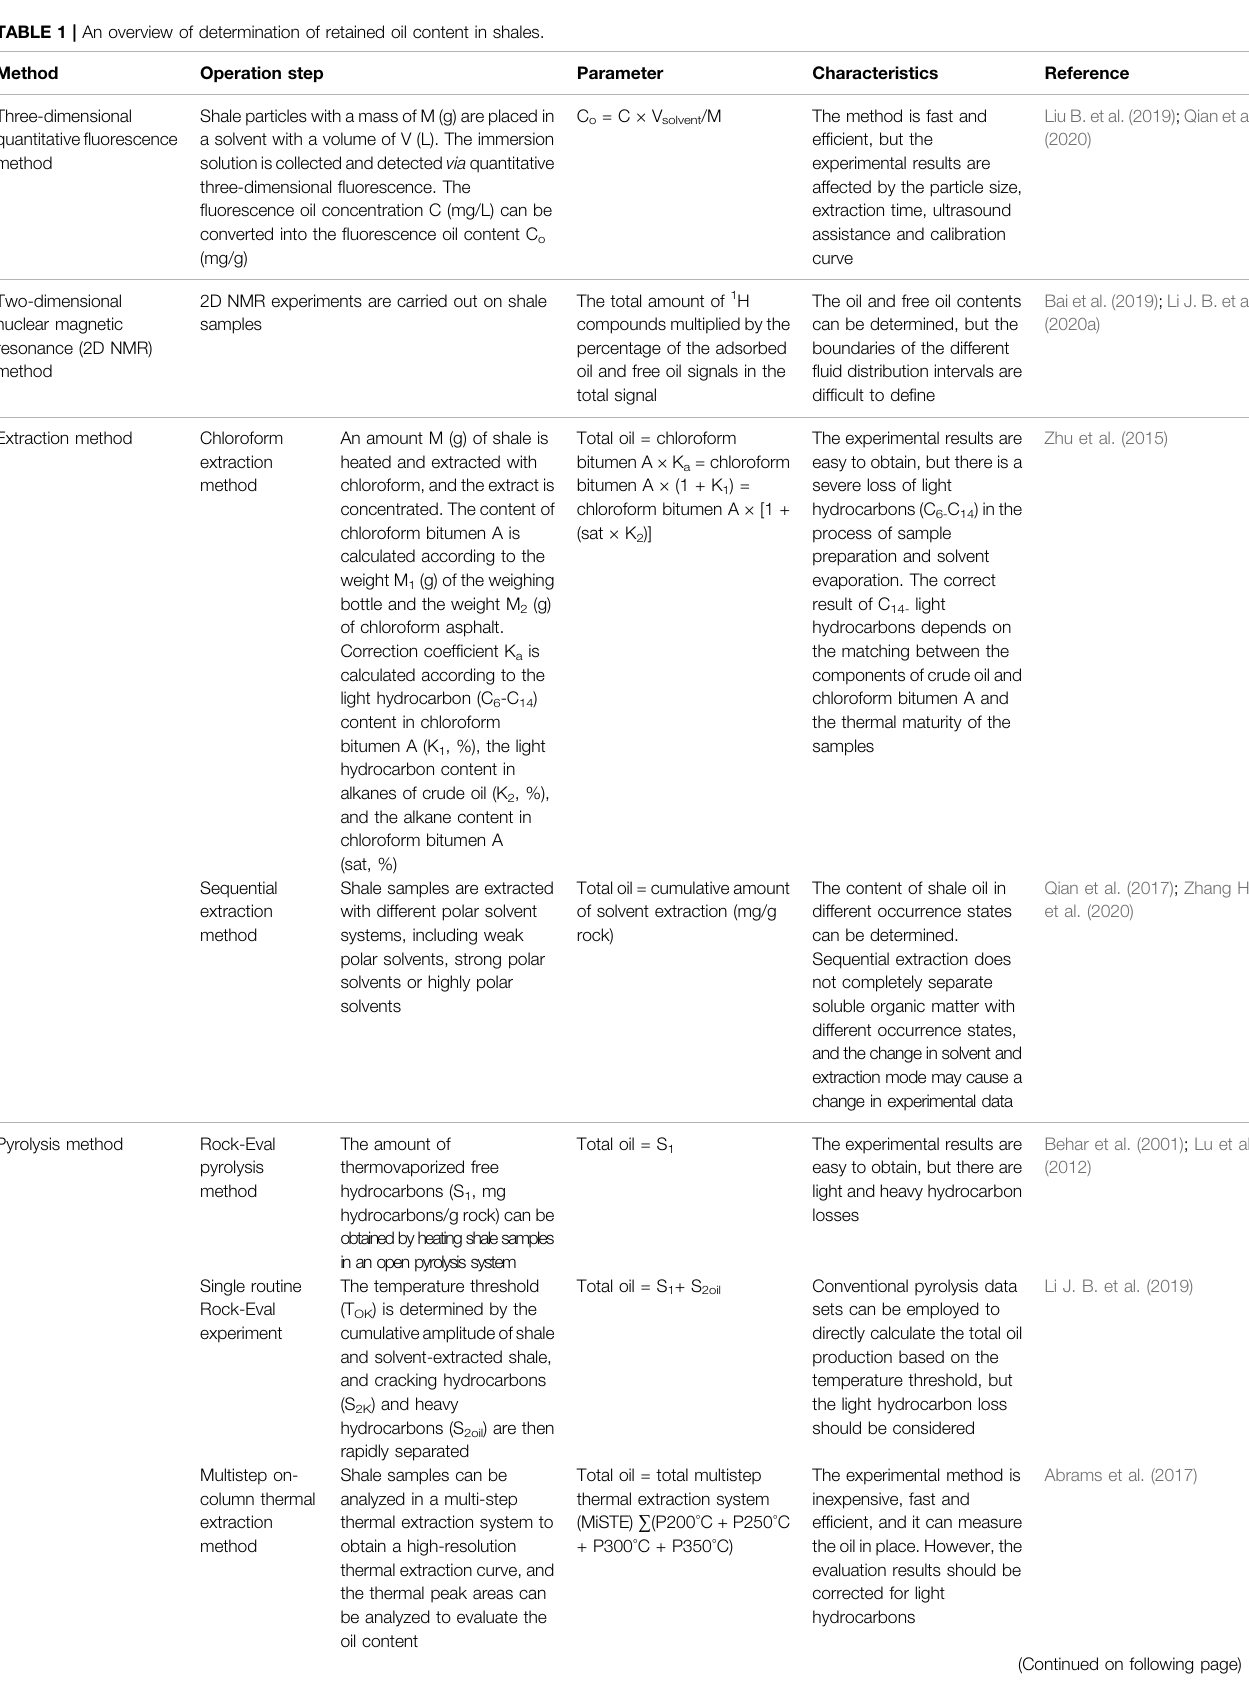
TABLE 1 | An overview of determination of retained oil content in